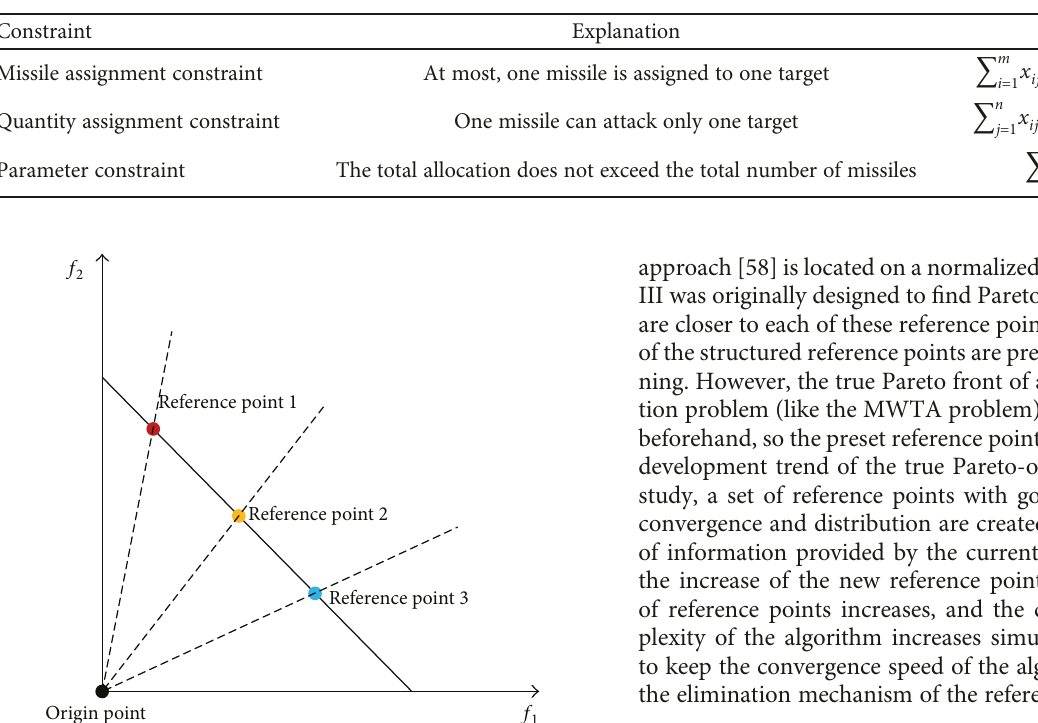
Table 4: Detailed information about the constraints.